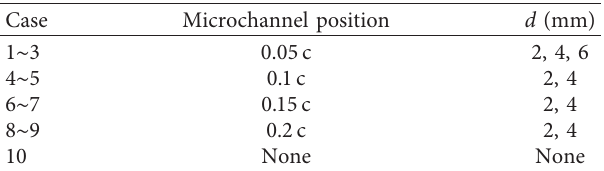
Figure 2: Computing mesh and mesh encryption around the foil. (a) Computational mesh. (b) Mesh encryption around the foil (head). (c) Mesh encryption at around the foil (tail). Table 1: Solving working conditions.